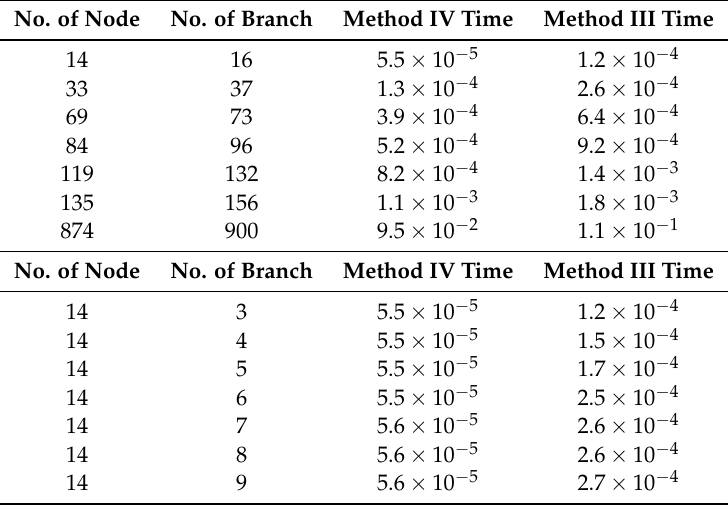
Table 5. Time to get the CVB